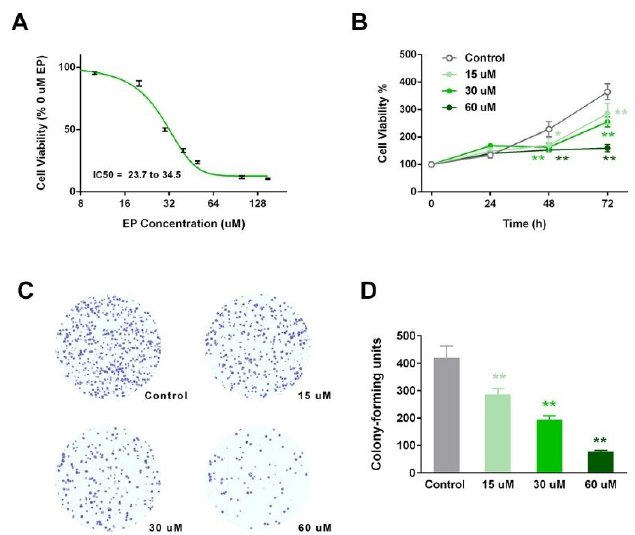
Figure 2. EP inhibited in vitro renal cell carcinoma (RCC)cell growth. ( A ) Suppressive curve of increasing EP concentrations, with an IC50 value of around 30 µM. ( B ) EP groups had a highly significantly lower viability compared with the control. ( C ) Stained colonies in a 12-day soft-agar experiment of four groups. ( D ) A significant decrease in colony number in EP groups. * p < 0.05; ** p < 0.01, vs. control.